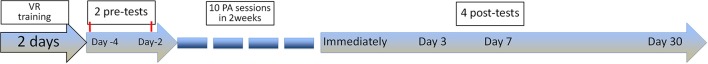
Experimental procedure. The procedure consisted of two pre-tests (at day−4 and day−2 prior to prism exposure) and four post-tests (immediately after prism removal; 0 h, and at 3, 7, and 30 days later). Each pre- or post-test consisted of subjective straight-ahead pointing test, VAP-S task, and drawings from memory task. VR, Virtual reality; PA, Prism adaptation.